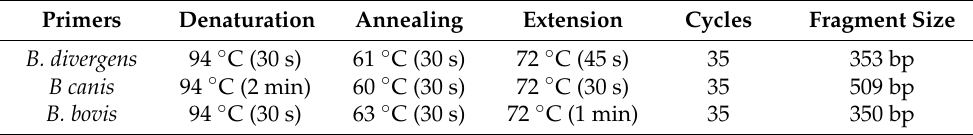
Table 2. Thermo-cycling conditions used in the amplification of the other